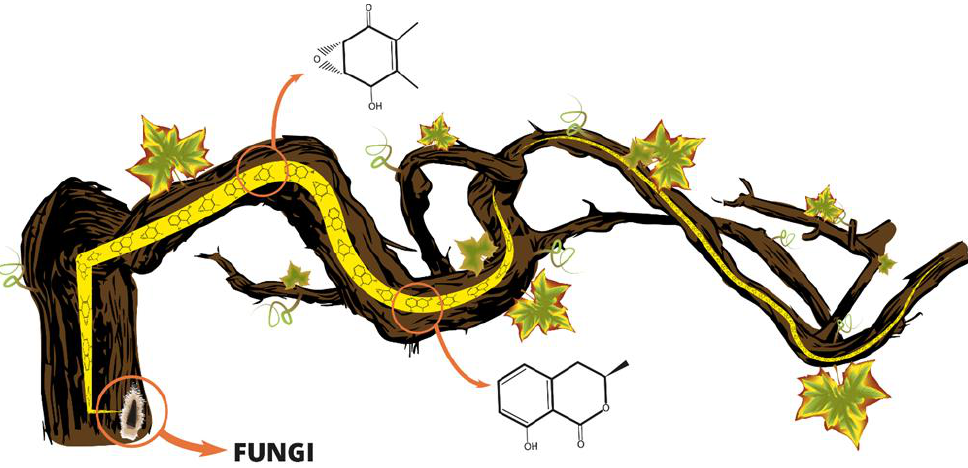
Figure 1. Schematic representation of the hypothesis that fungal phytotoxins are able to translocate within a vine resulting in foliar symptoms.